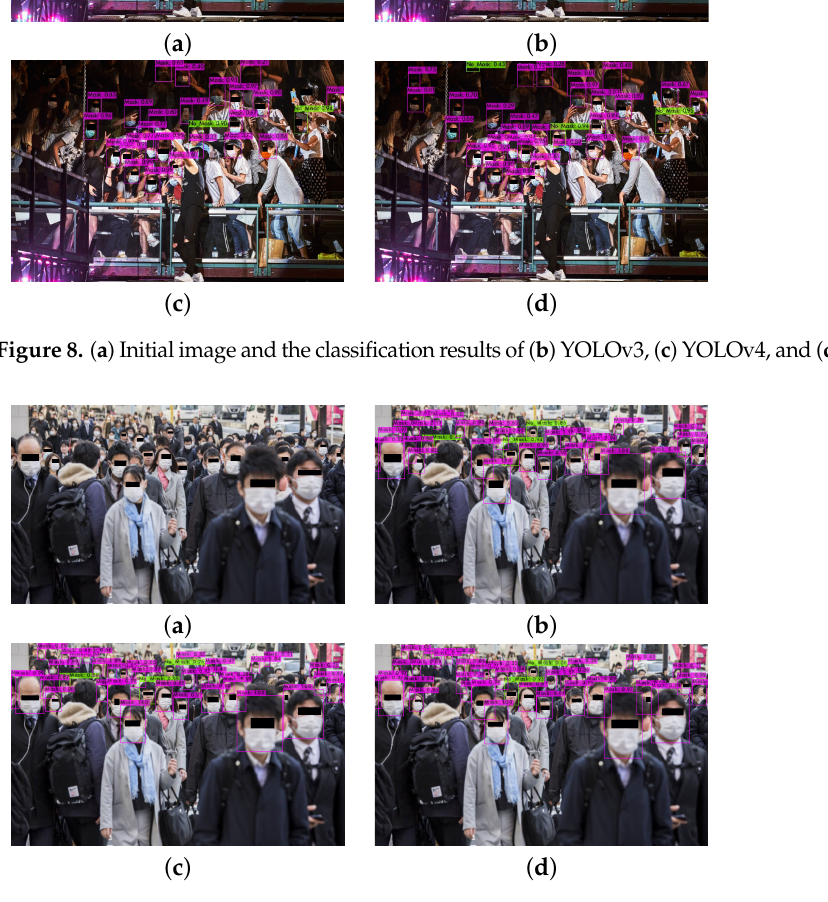
Figure 9. ( a ) Initial image and the classification results of ( b ) YOLOv3, ( c ) YOLOv4, and ( d ) YOLOv4-tiny.